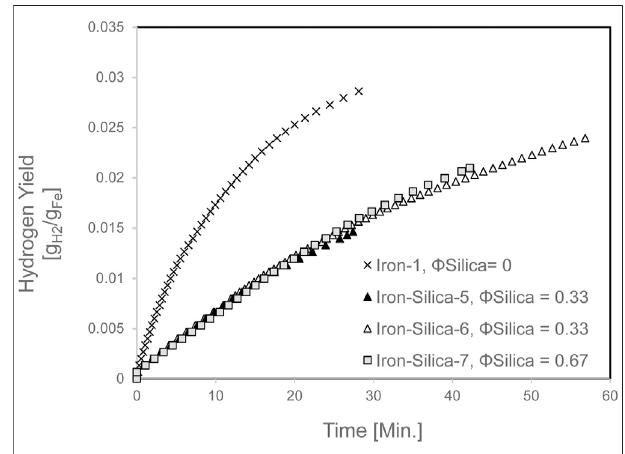
FIGURE 5 | Hydrogen yield for mixed iron and silica (200 – 300 µm) with various silica volume fractions at 650 ° C (set furnace temperature).